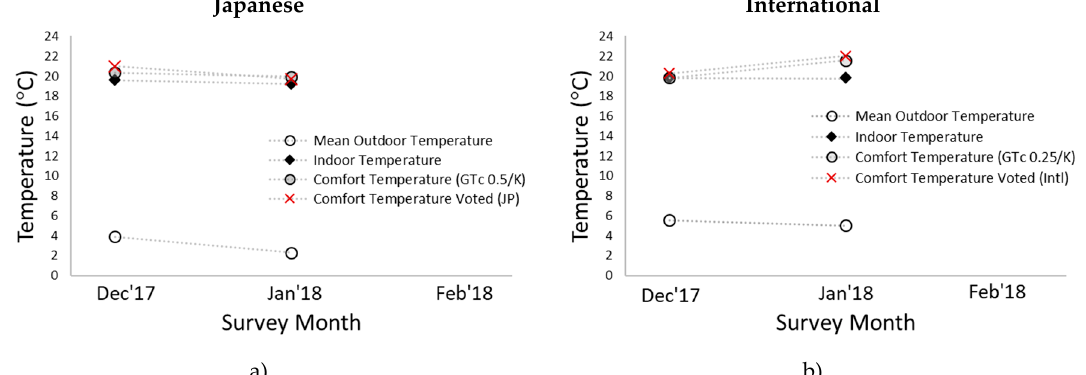
Figure 15. Comparing mean temperatures in each survey month ( a ) Japanese dataset; ( b ) international